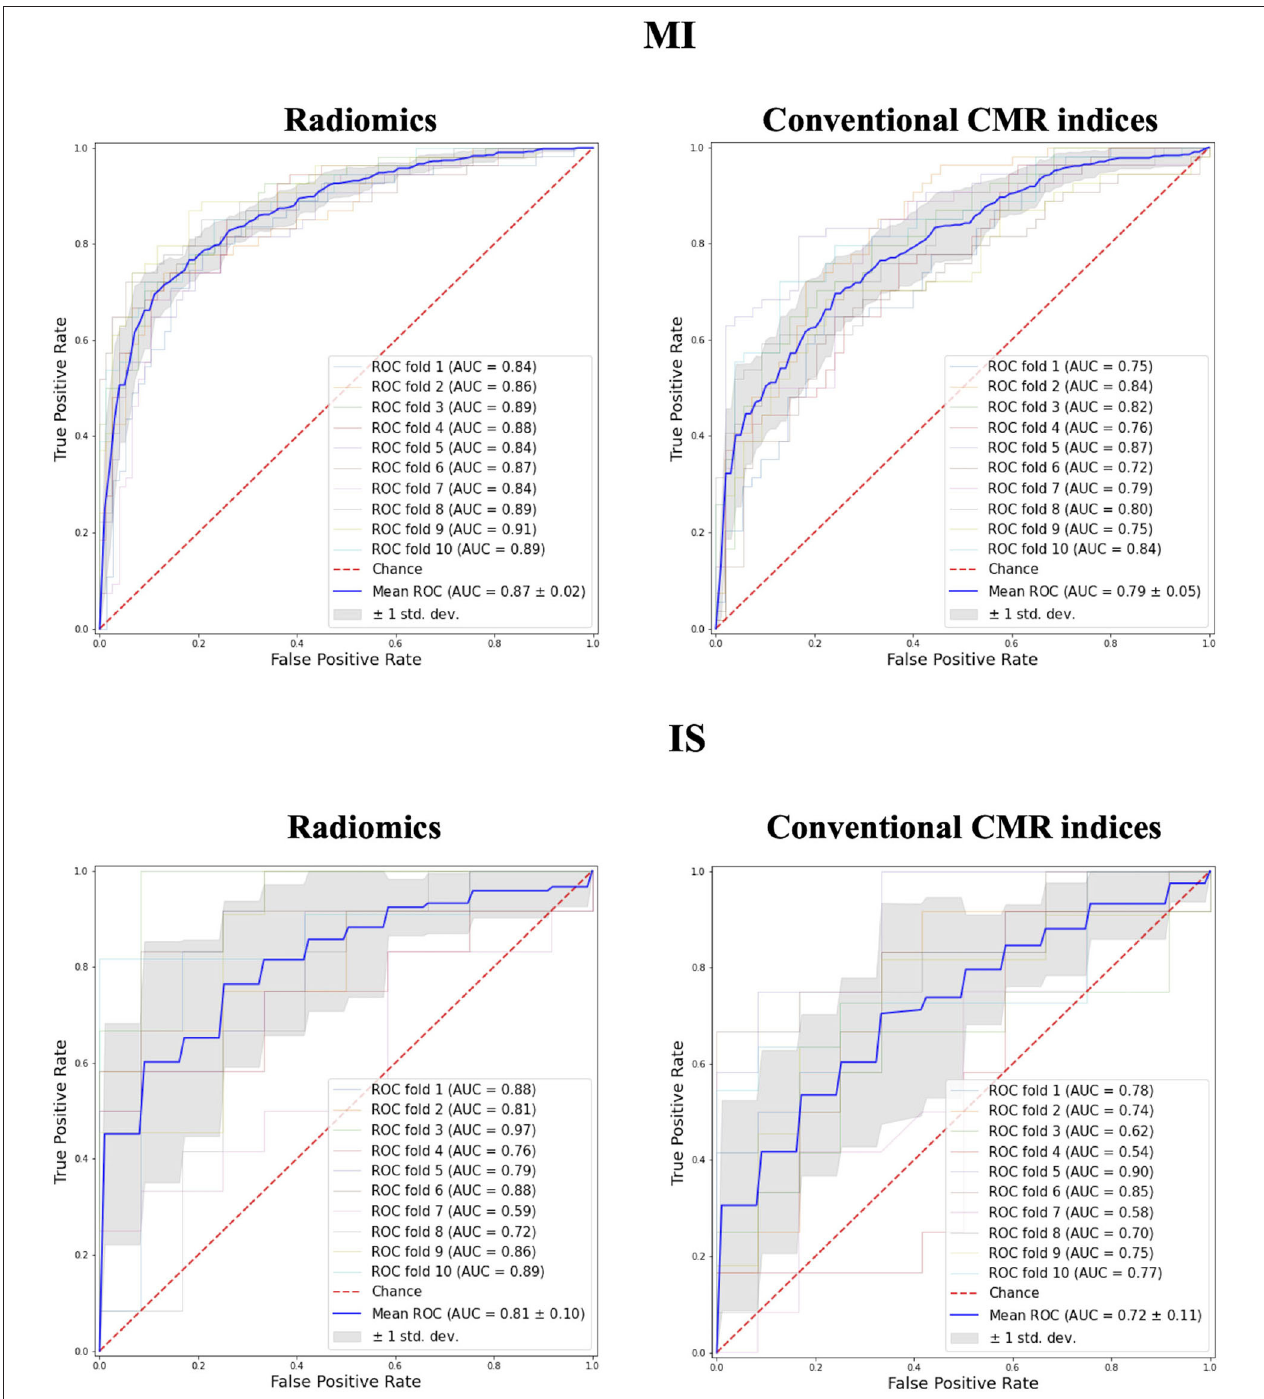
FIGURE 3 | Receiver operating curves for radiomics vs. conventional CMR indices models in MI and IS groups. MI, myocardial infarction; IS, ischaemic stroke; AUC, Area under the